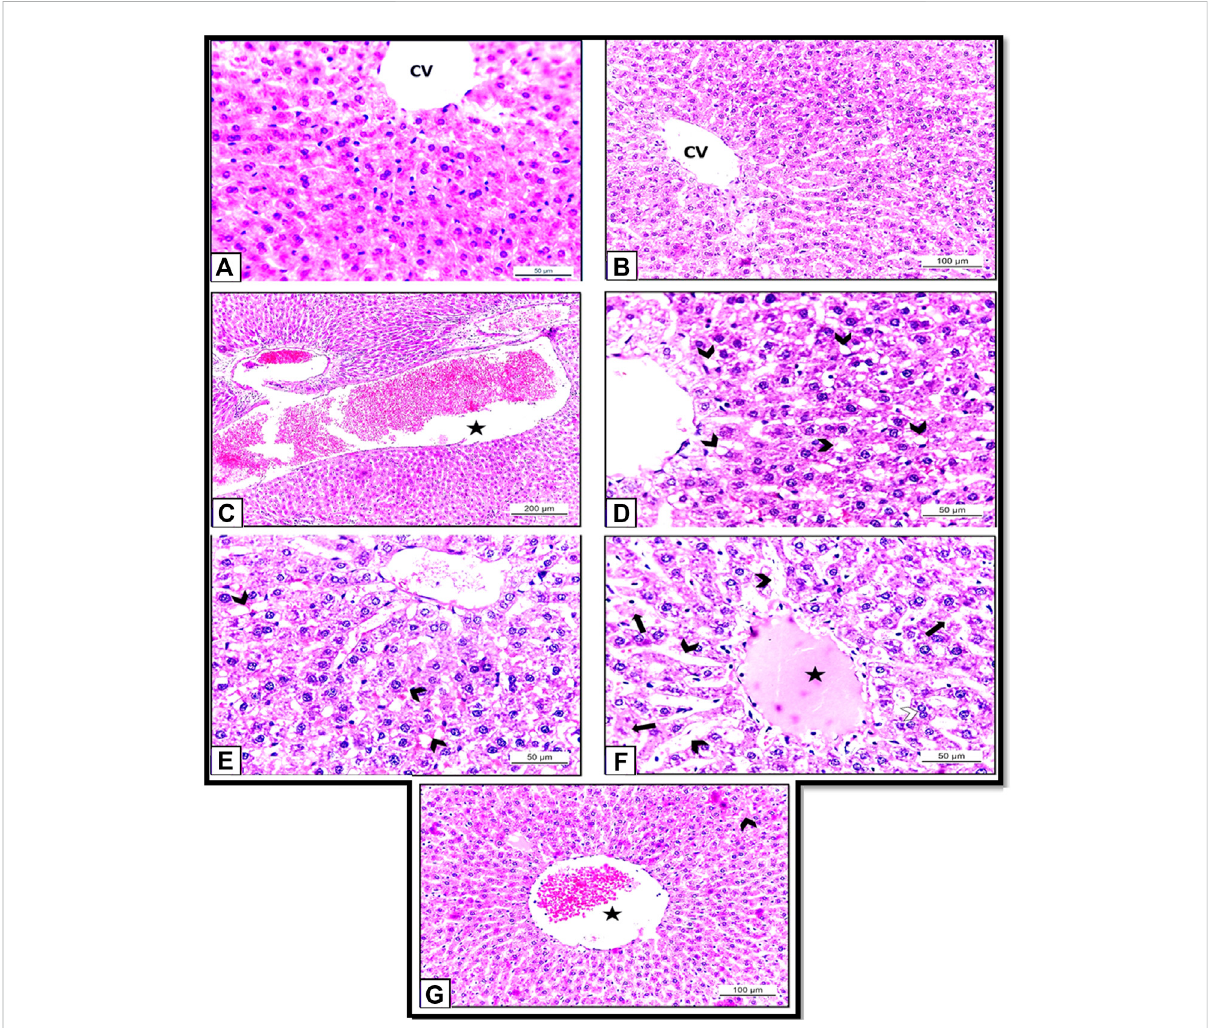
FIGURE 7 (A) : Section of albino rat ’ s liver of Control group (Group I) showing normal hepatic architecture with central vein and radiating cords of normal hepatocytes with central rounded vesicular nuclei. H&E X400. (B) : Section of albino rats ’ liver of HSP group (Group III) also showing normal hepatic architecture with hepatic cords separated by blood sinusoids. H&E X 200. (C – F) : Sections of albino rats ’ livers of NiO-NPs group (Group II). (C) : Showing blood vessels are dilated and engorged with blood (star). H&E X100. (D) : Showing vacuolar degeneration of the hepatocytes (arrow heads). H&E X400. (E) : showing dilated blood sinusoids (arrow heads). H&E X 400. (F) : Showing dilated blood sinusoids (arrow heads), hyalinization (star),degeneratedhepatocytes (arrows).H&E X400. (G) :Sectionofalbino rat ’ sliverofNiO-NPs+ HSP group(Group IV) showing slightlycongested central vein (star) with a decrease in the degenerated hepatocytes (arrow head). H&E X